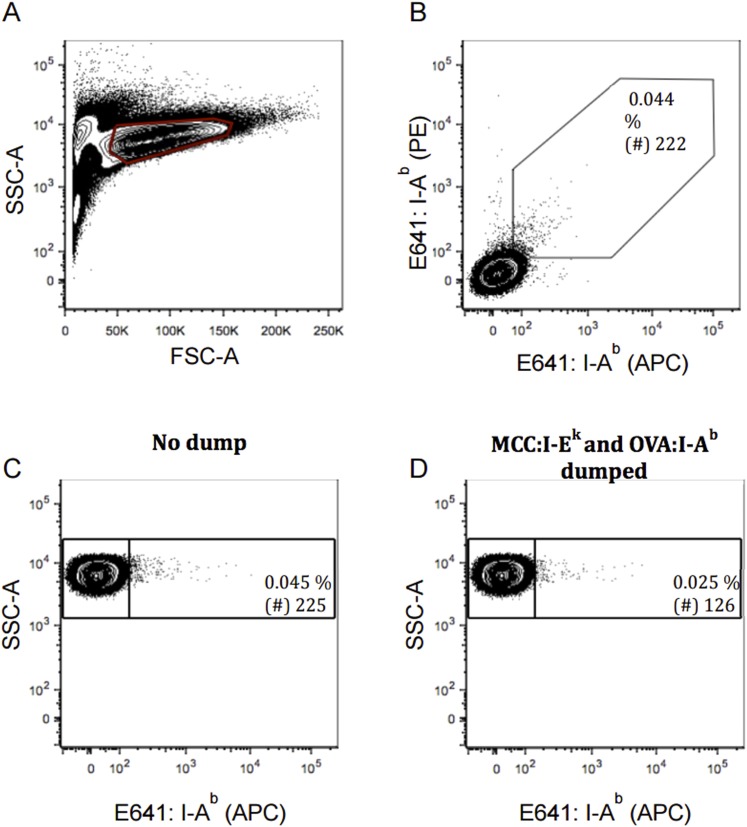
Exclusion of false-positive cells by two-color and dump tetramer analysis modeled with TCR negative T cell hybridoma. TCR negative 58α-β- cells were incubated with E641: I-Ab tetramer in two color as in Figure 3 or with E641: I-Ab, OVA: I-Ab and MCC: I-Ek tetramers with single color as in Figure 4. Contour plot showing our (A) live 58α-β- cells; (B) 58α-β- cells incubated with E641: I-Ab (APC) and (PE) for two-color analysis; or 58α-β- cells staining positive for E641: I-Ab tetramer (C) pre and (D) post dump of cells bound to OVA: I-Ab and MCC: I-Ek. Percent and number (of 500,000 58α-β- cells) of cells bound to E641: I-Ab tetramer are shown in inset.